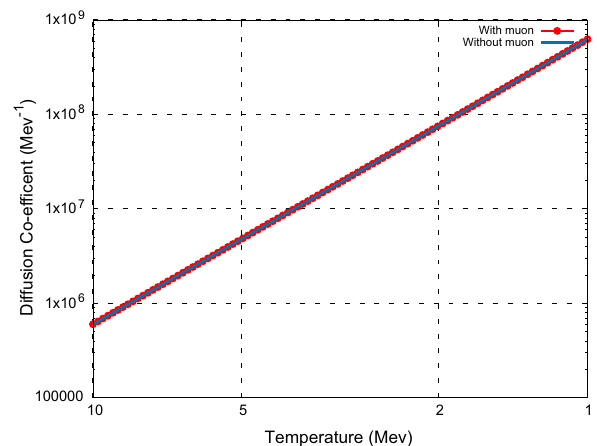
Fig. 2 Diffusion coefficient of protons in the electron, neutron and muon plasma. The (black) dashed line denotes x e < x μ and the (red) dot- dashed line denotes x e ≈ x μ